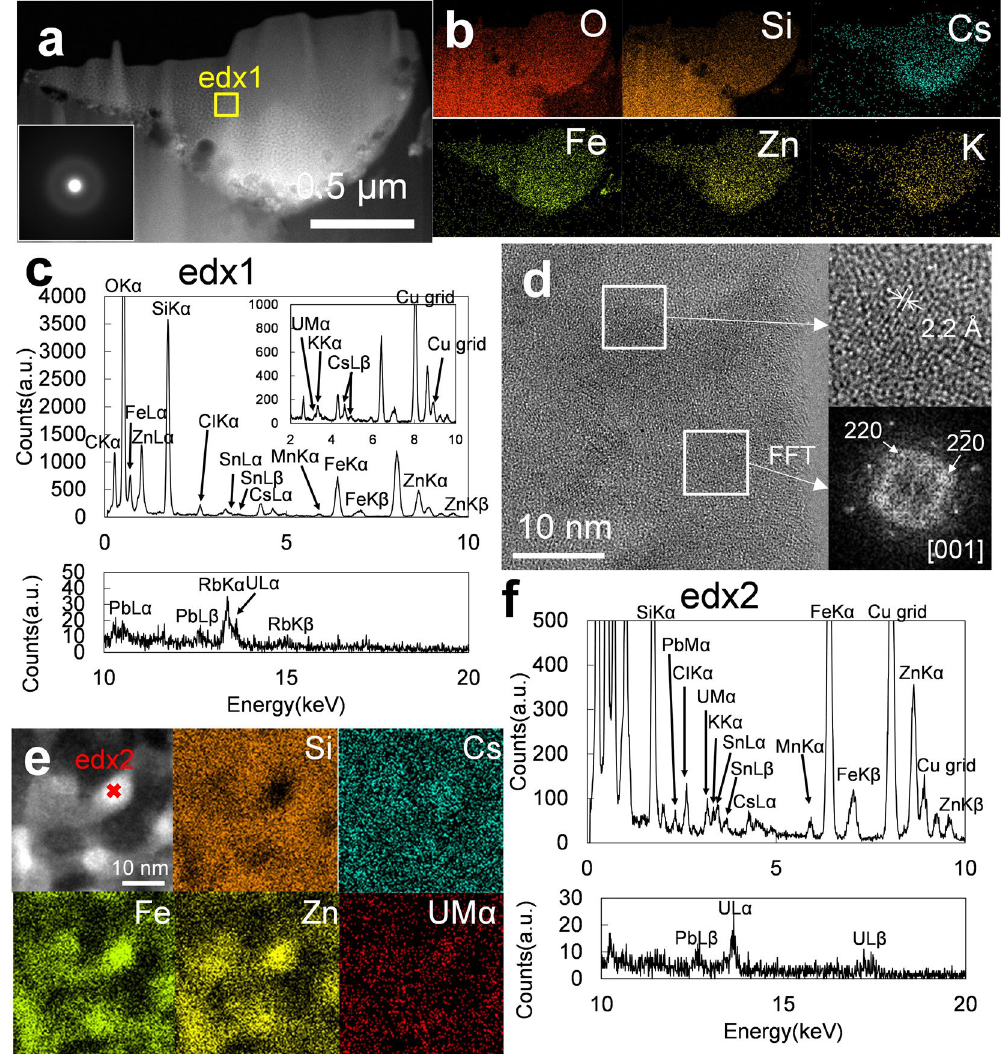
Figure 5. ( a ) HAADF-STEM image of the FIB-TEM specimen of the OTZ10 CsMP with the SAED as inset. ( b ) Elemental maps of the same area as the HAADF-STEM image in ( a ). ( c ) The EDX spectrum of the area indicated by the yellow square labeled as edx1 in ( a ). ( d ) A HRTEM image of the Zn–Fe-oxides nanoparticles accompanied with the magnified lattice image and the FFT image of the selected area indicated by the white square. The lattice fringe of 2.2 Å corresponds to (400). ( e ) HAADF-STEM image of the enlarged figure of the thin edge in ( a ) associated with elemental maps. ( f ) STEM-EDX point analysis on a Zn–Fe-oxide nanoparticle indicated by a red cross labeled as edx2 in ( e